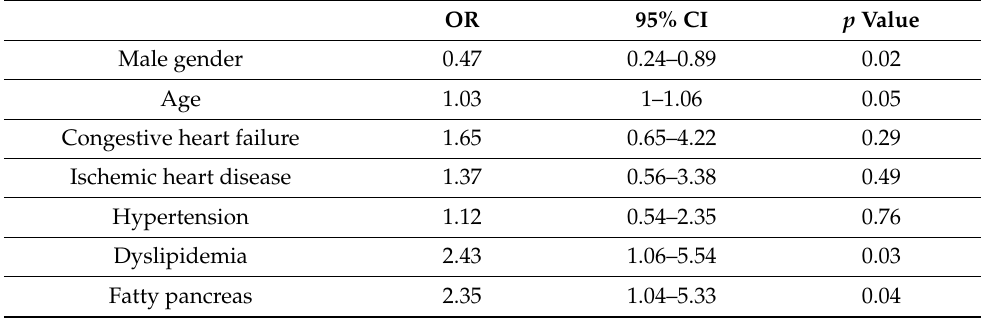
Table 3. Multivariate logistic regression analysis of parameters associated with